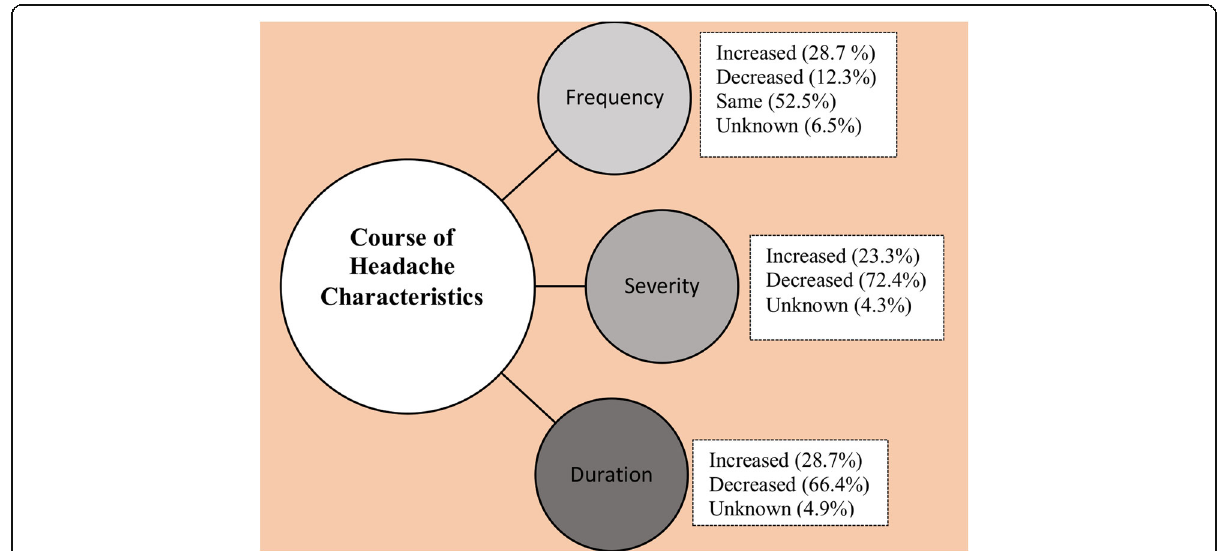
Fig. 3 The course of headache characteristics